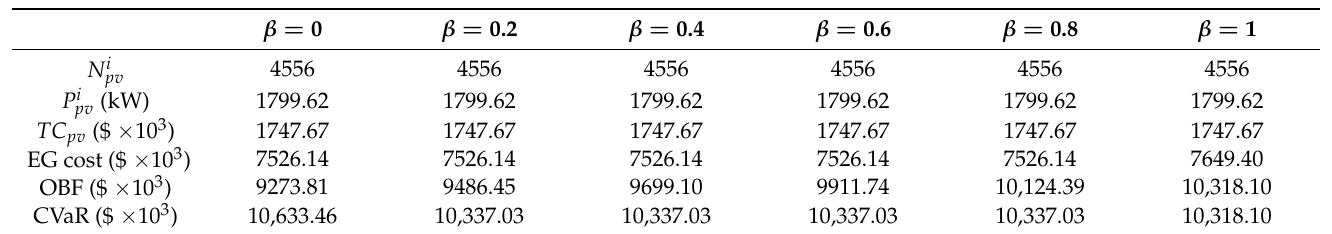
Table 10. Results including all